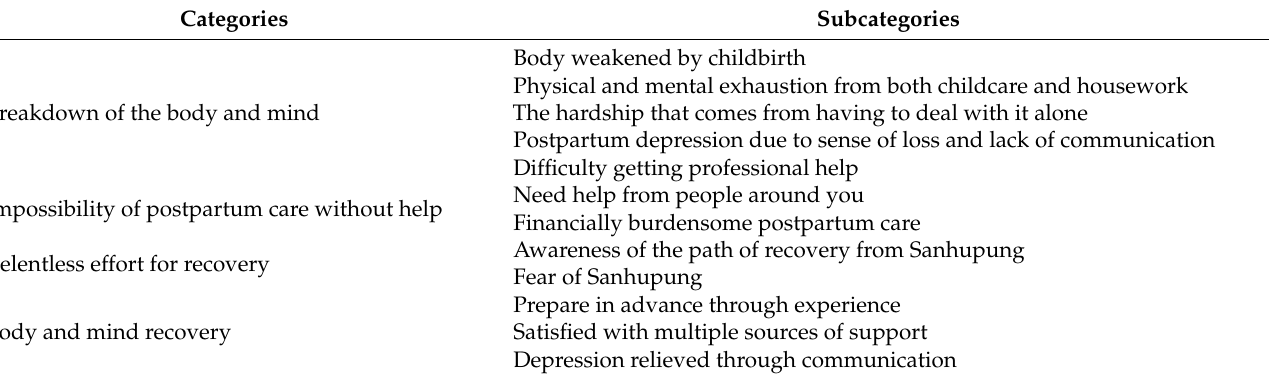
Table 2. Analysis of participants’ experience and awareness of childbirth and postpartum